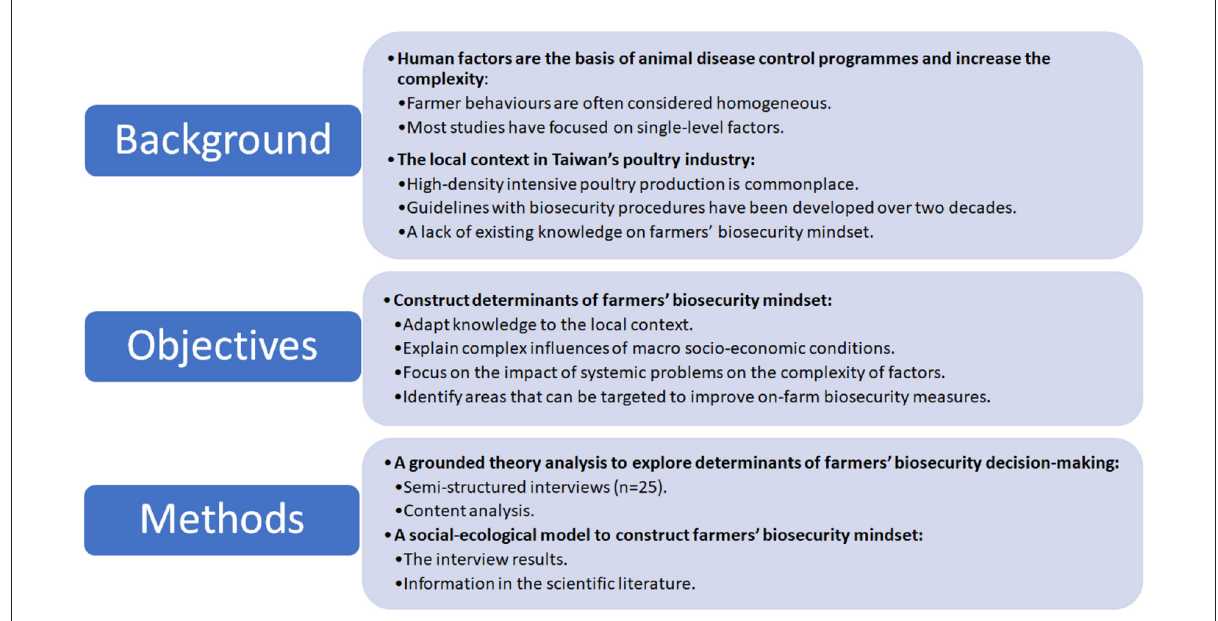
FIGURE2 The framework of the study. The opinions of Taiwan’s chicken farmers were directly explored through semi-structured interviews, and a grounded theory analysis was performed. By integrating themes and sub-themes revealed in this study together with the literature, a modified six-level social-ecological model was constructed to explain the complex influences of macro socio-economic conditions on farmers’ biosecurity